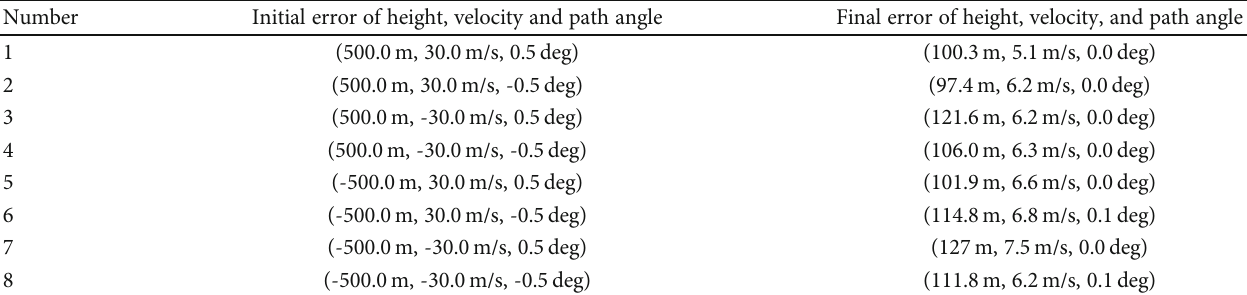
Table 2: The fi nal errors of AMPI